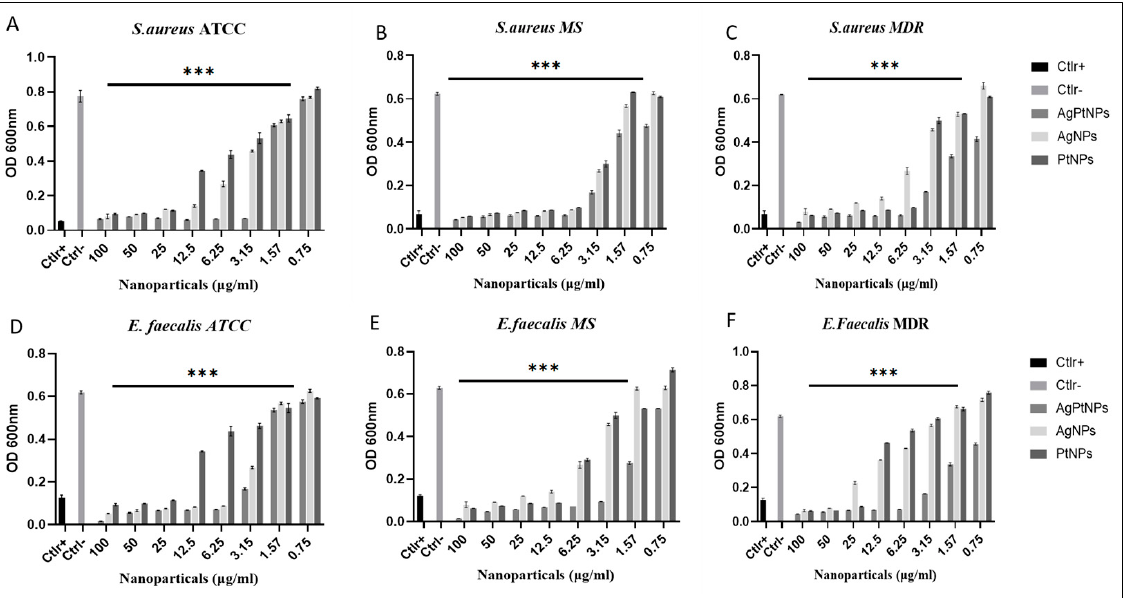
Figure 7. Analysis of AgPtNPs by MIC against ATCC, MS and MDR Gram-positive. ( A – C ) indicate the analysis against all S. aureus strains and ( D – F ) against E. faecalis. Ctlr+ indicates bacteria treated with antibiotic, while Ctlr − represents non-treated bacteria. Data are relative to Ctlr – and represent the mean ± standard deviation (SD). Significant diff. among means (*** p < 0.05).